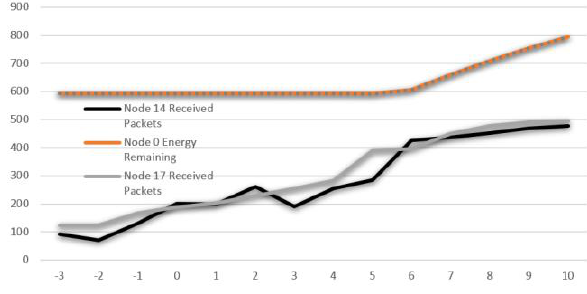
Figure 13. Remaining Energy and Packets Sent/Received vs Transmission Power under Scenario 2b